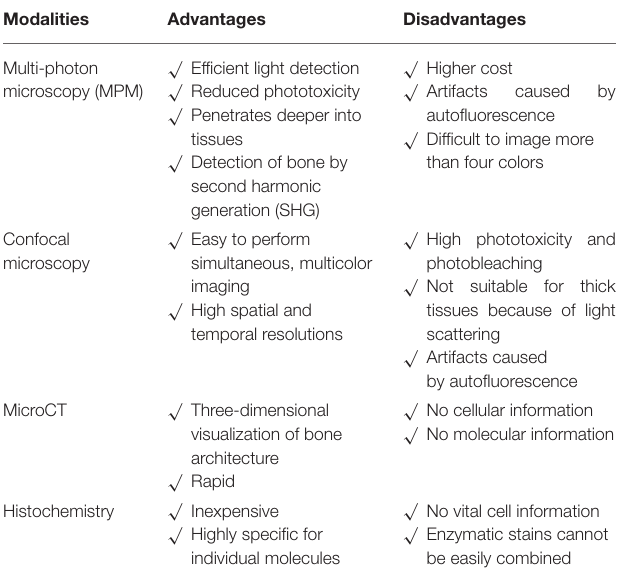
TABLE 1 | Comparison of different modalities used for bone